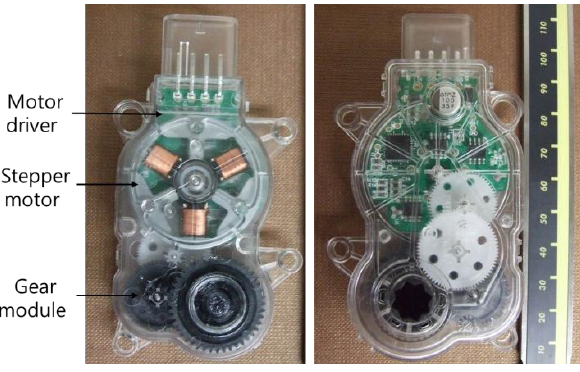
Figure 8. Actuator prototypes of the AGS system: ( a ) upper side and ( b ) lower side.